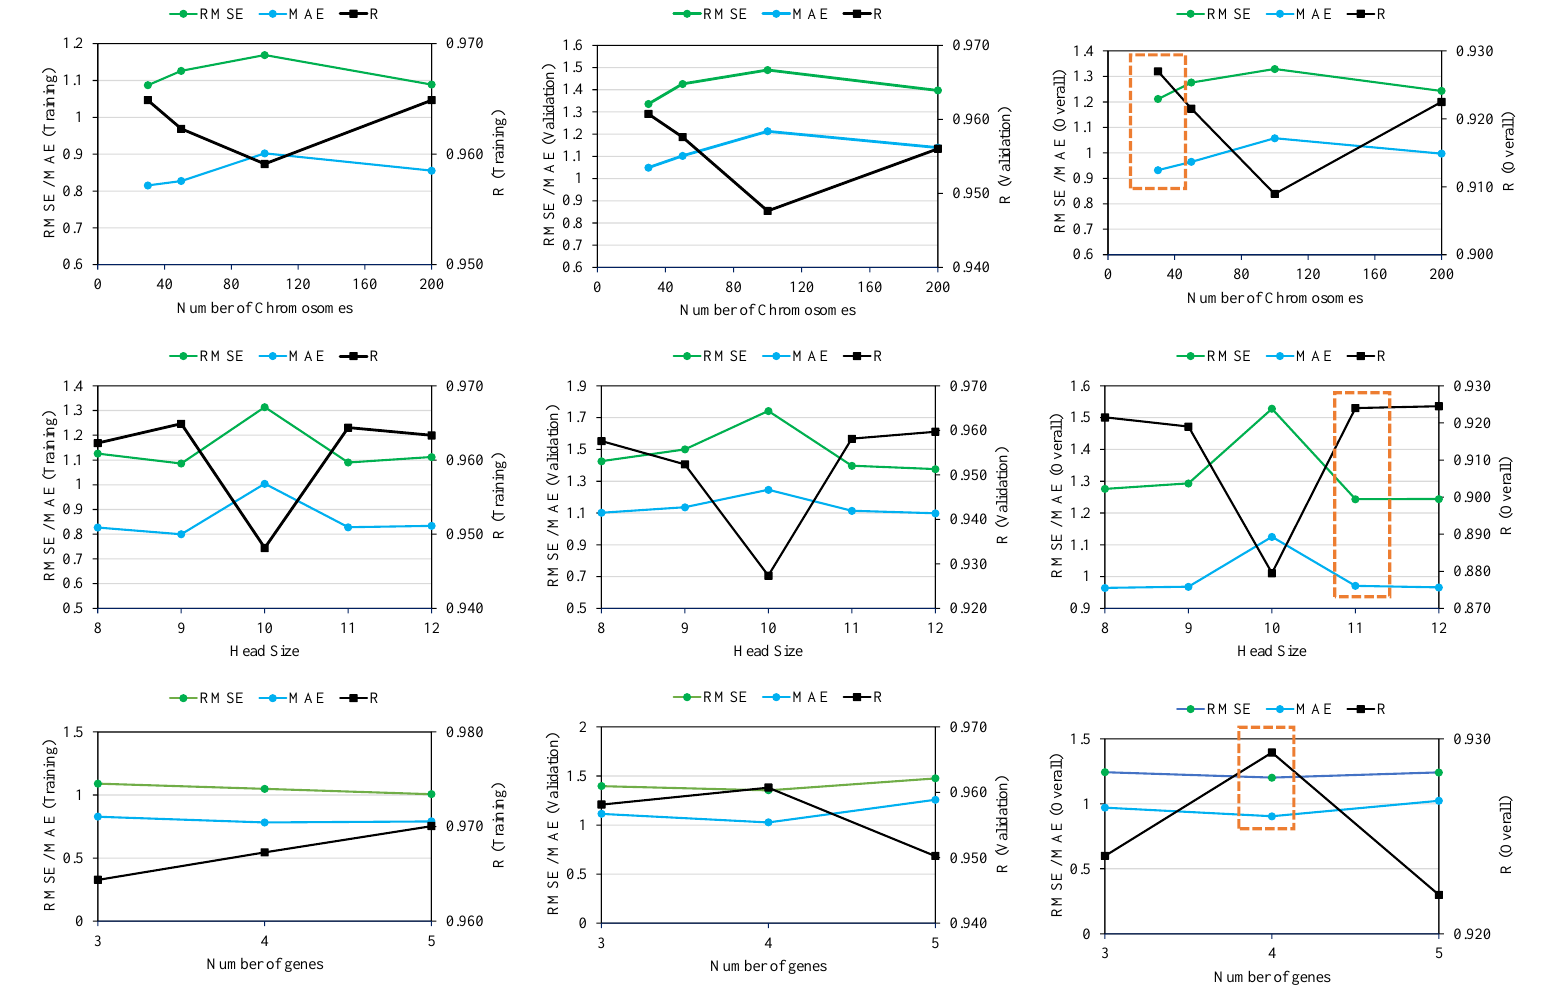
Figure 4. Effect of variable genetic parameters on the performance of the models (orange boxes show the optimized overall performance based on number of chromosomes, head size and genes).